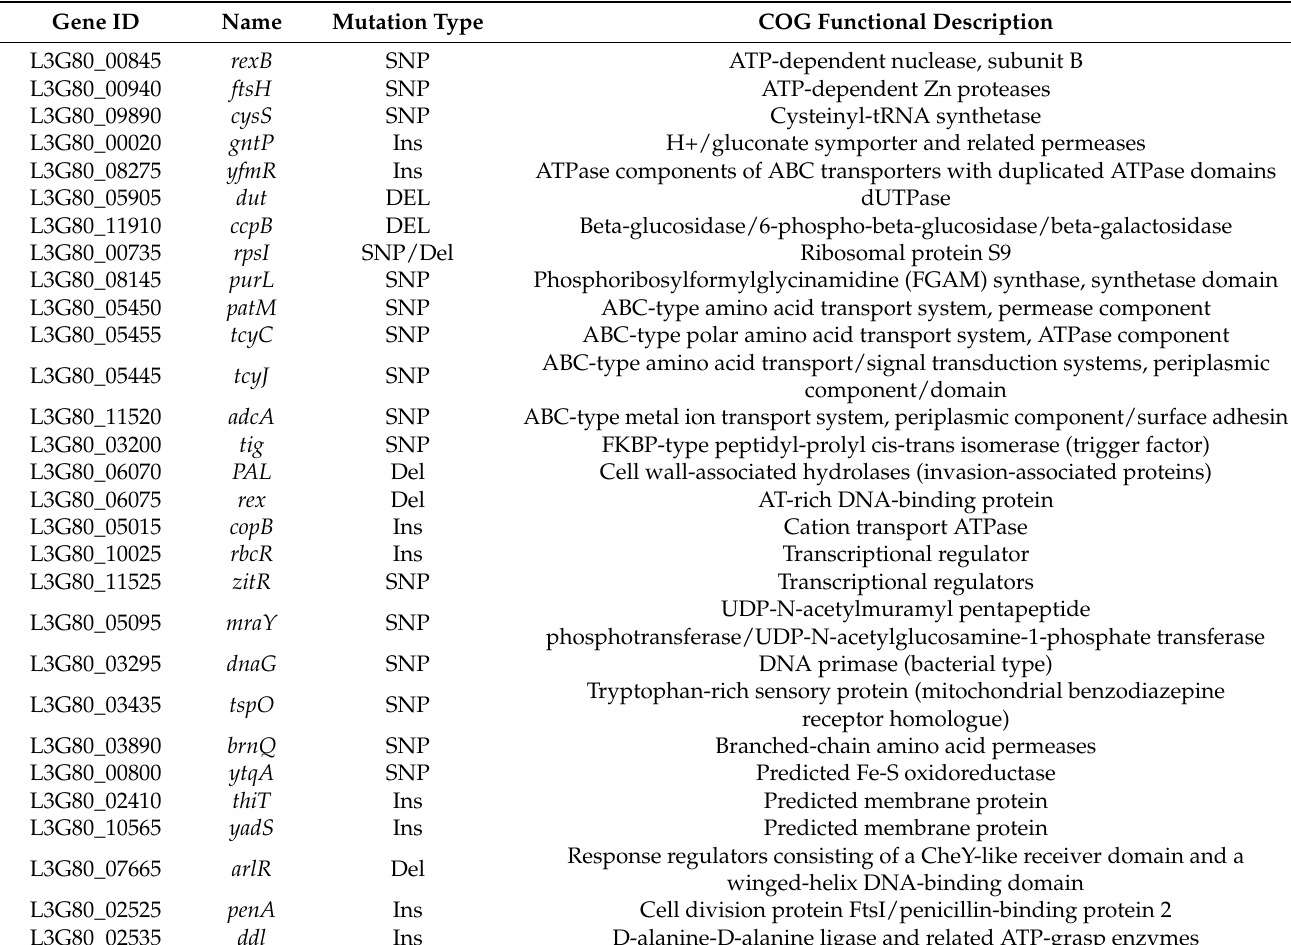
Table 3. COG analysis and type of gene